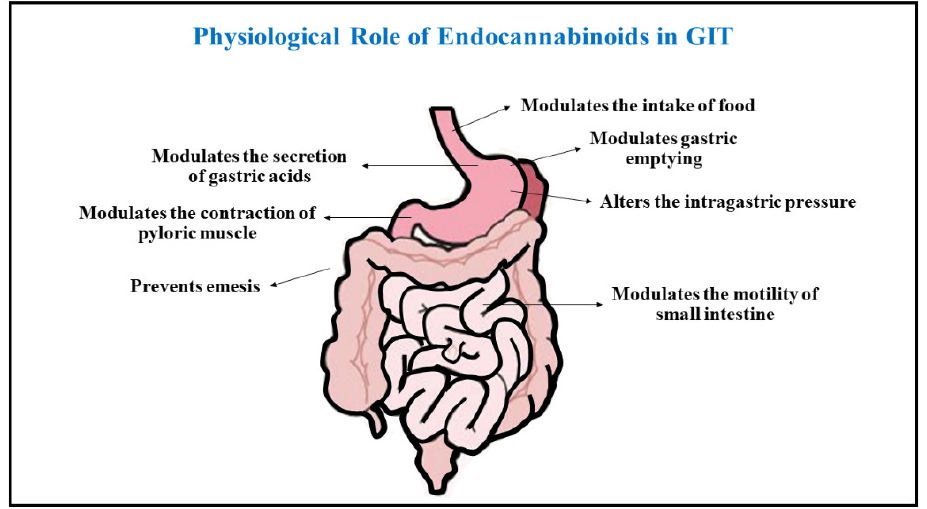
Figure 2. The figure describes a collective overview on physiological roles attained by endocanna- binoids in the management of gastrointestinal